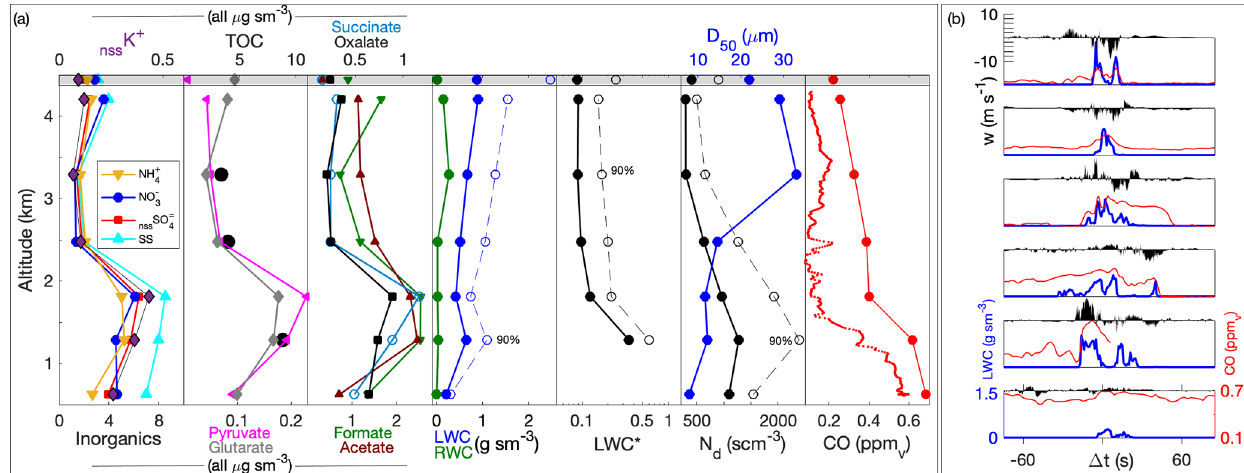
Figure 14. (a) Profiles of key CW species during the Case III cloud module and supporting microphysical (LWC, RWC, adiabatic ratio (LWC ∗ ), N d , volume-based median diameter, D 50 ) and gas tracer (CO) data. Also shown alongside CO is the CO profile in the nearby (cloud-free) environment. Included in the grey-shaded region is the corresponding data from a cloud top penetration near the upwind transect (yellow marker, Fig. 2; see text). (b) Thumbnail time-series plots ( ± 75s from center lines) of the six cloud penetrations corresponding to the CW samples showing LWC, CO and w , with all plots equally